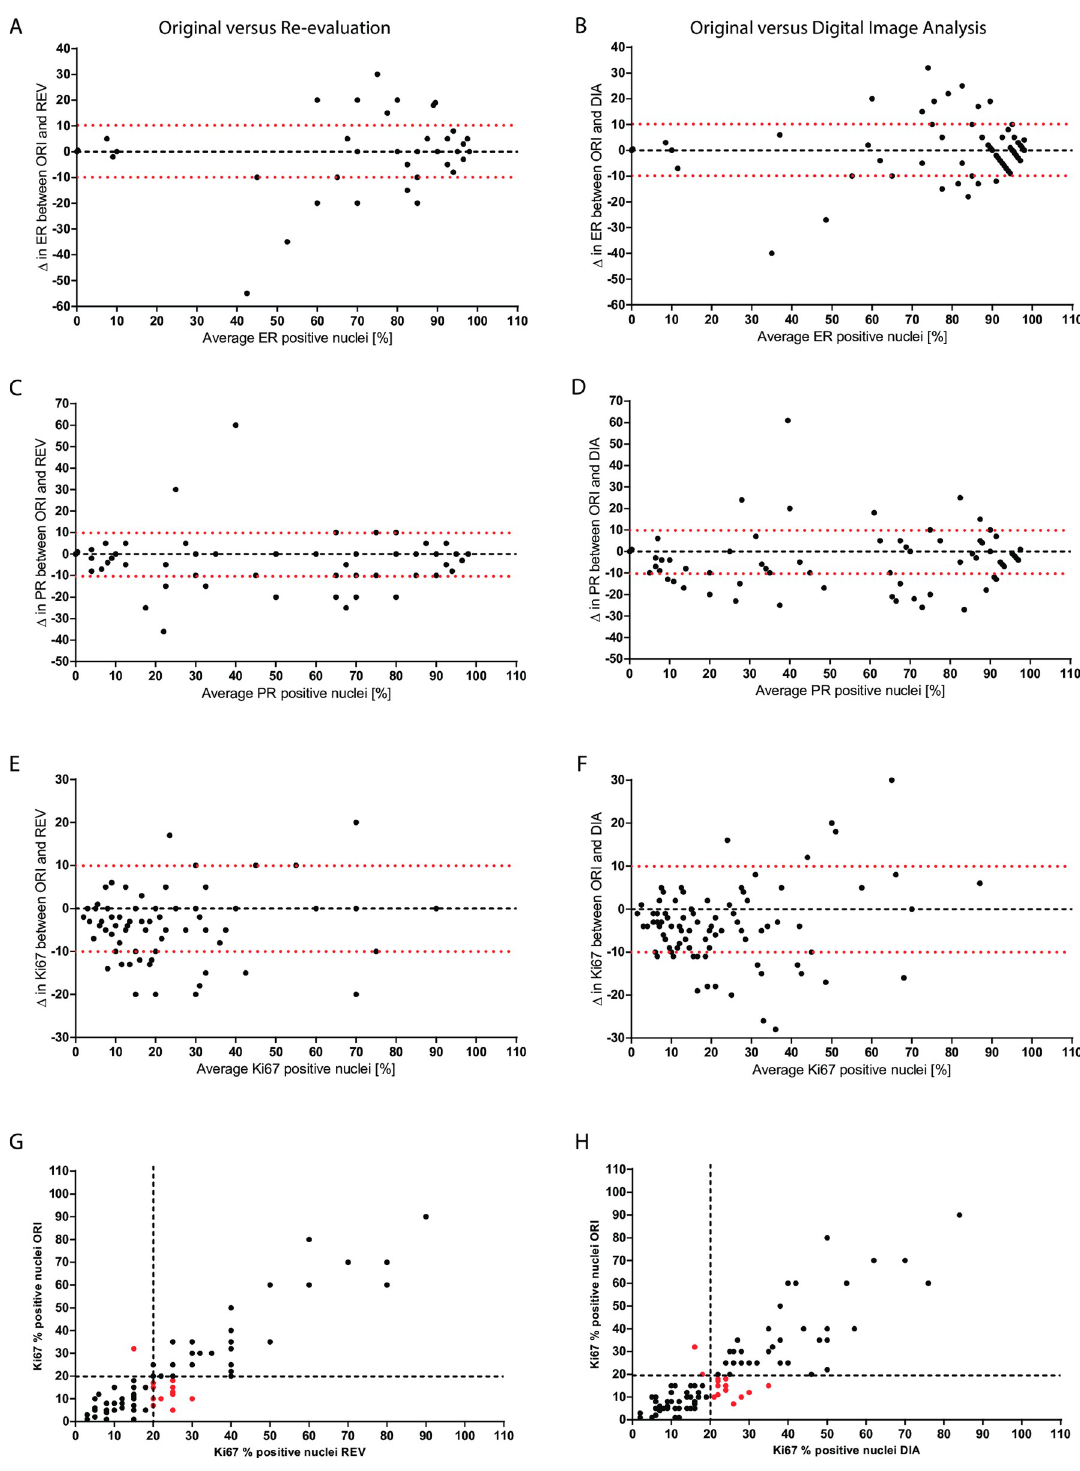
Fig 2. Correlation between original (ORI) and paired re-evaluated (REV) or digital image analyzed (DIA) samples for IHC. Bland- Altman plots showing differences between original, re-evaluated and digital image analysis for ER (A, B), PR (C, D) and Ki67 (E, F). Cut-off value at ± 10% is shown by red dotted lines. Scatterplots showing correlation between original, re-evaluated and digital image analysis for Ki67 (G, H). Cut-off value at 20% for Ki67 is shown by black dotted lines. Red dots highlight discordant cases between original and either re-evaluated or digital image